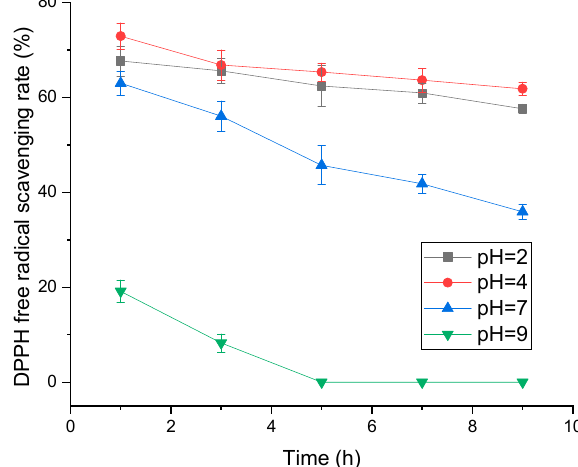
Figure 5. The antioxidant activity of polyphenol from distiller’s grain in different environments with pH of 2, 4, 7, and 9 at room temperature in dark.